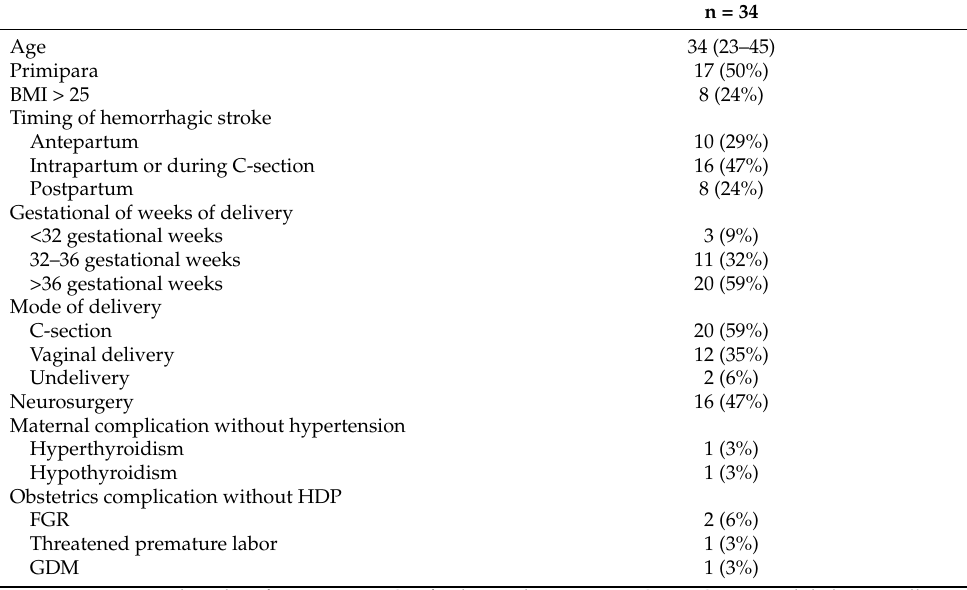
Table 1. Maternal background.